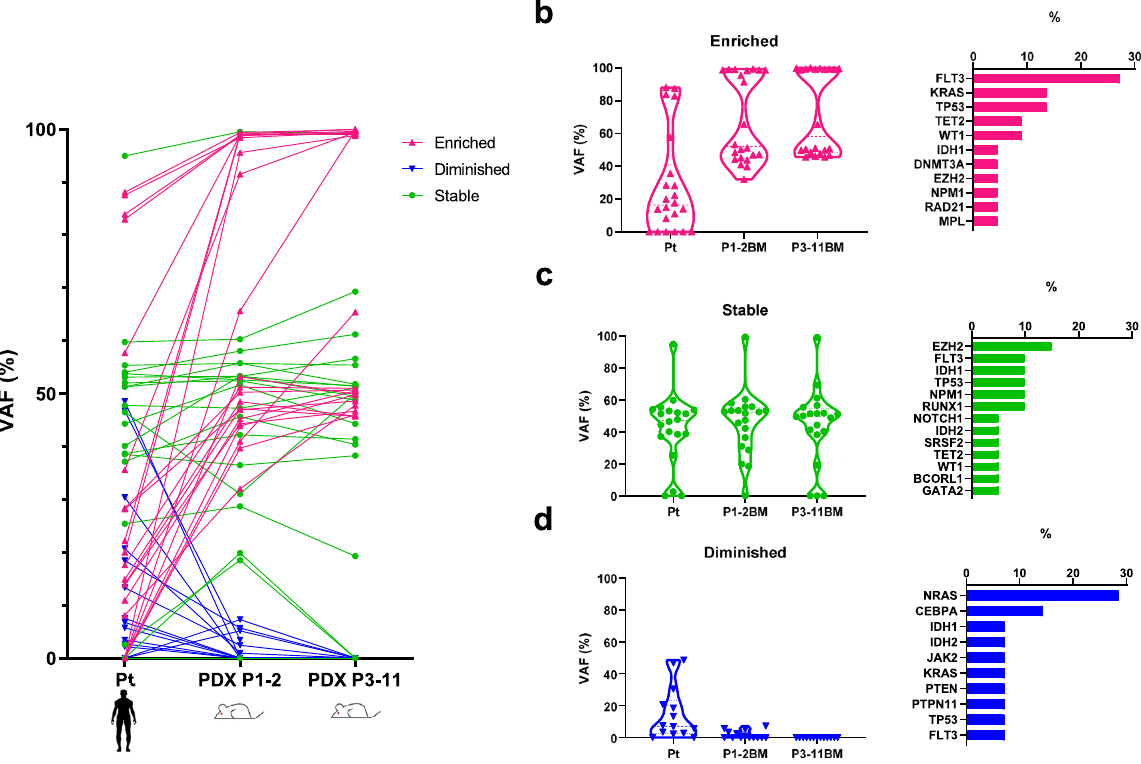
Fig. 4 Clonal selection occurs in AML-PDX models through PDX passaging. a VAF (%) of primary samples and PDX after serial passaging. Each dot plot indicates the same single alteration ( n = 56). b – d Violin plots of the VAF of variants showing b enrichment, c overall similarity, and d reductions from primary through P1-2 to ≥ P3 PDX datasets. The relative proportions of genes included in each group are shown in the bar plot. Source data are provided as a Source Data fi le.